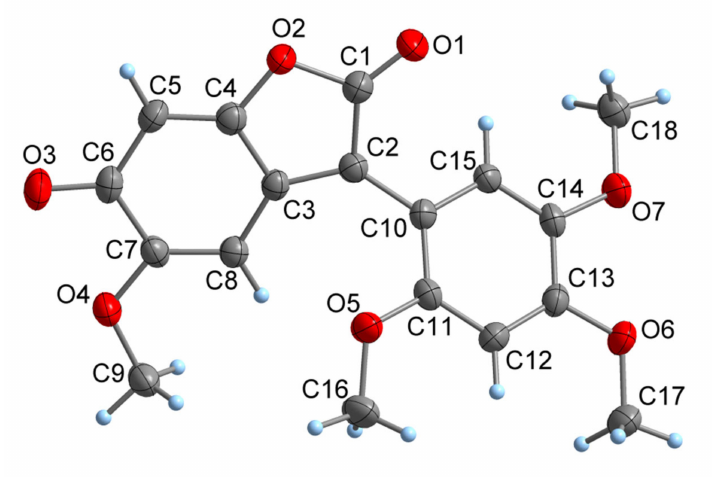
Figure 4. The molecular structure of compound 6 in the crystal. Displacement ellipsoids of C and O atoms drawn at the 50% probability level, H atoms as spheres of arbitrary size.